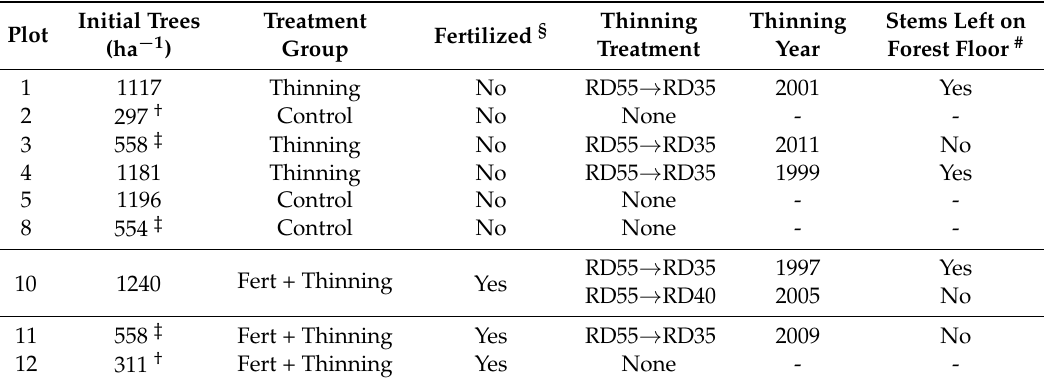
Table 1. Summary of plot treatments. The plantation was planted in 1977 with 2-year-old Douglas-fir seedlings. Plots are each 0.2-ha and span a total area of ~5 ha. Fert, fertilized. Initial Trees Treatment Plot Fertilized (ha − 1 ) Group